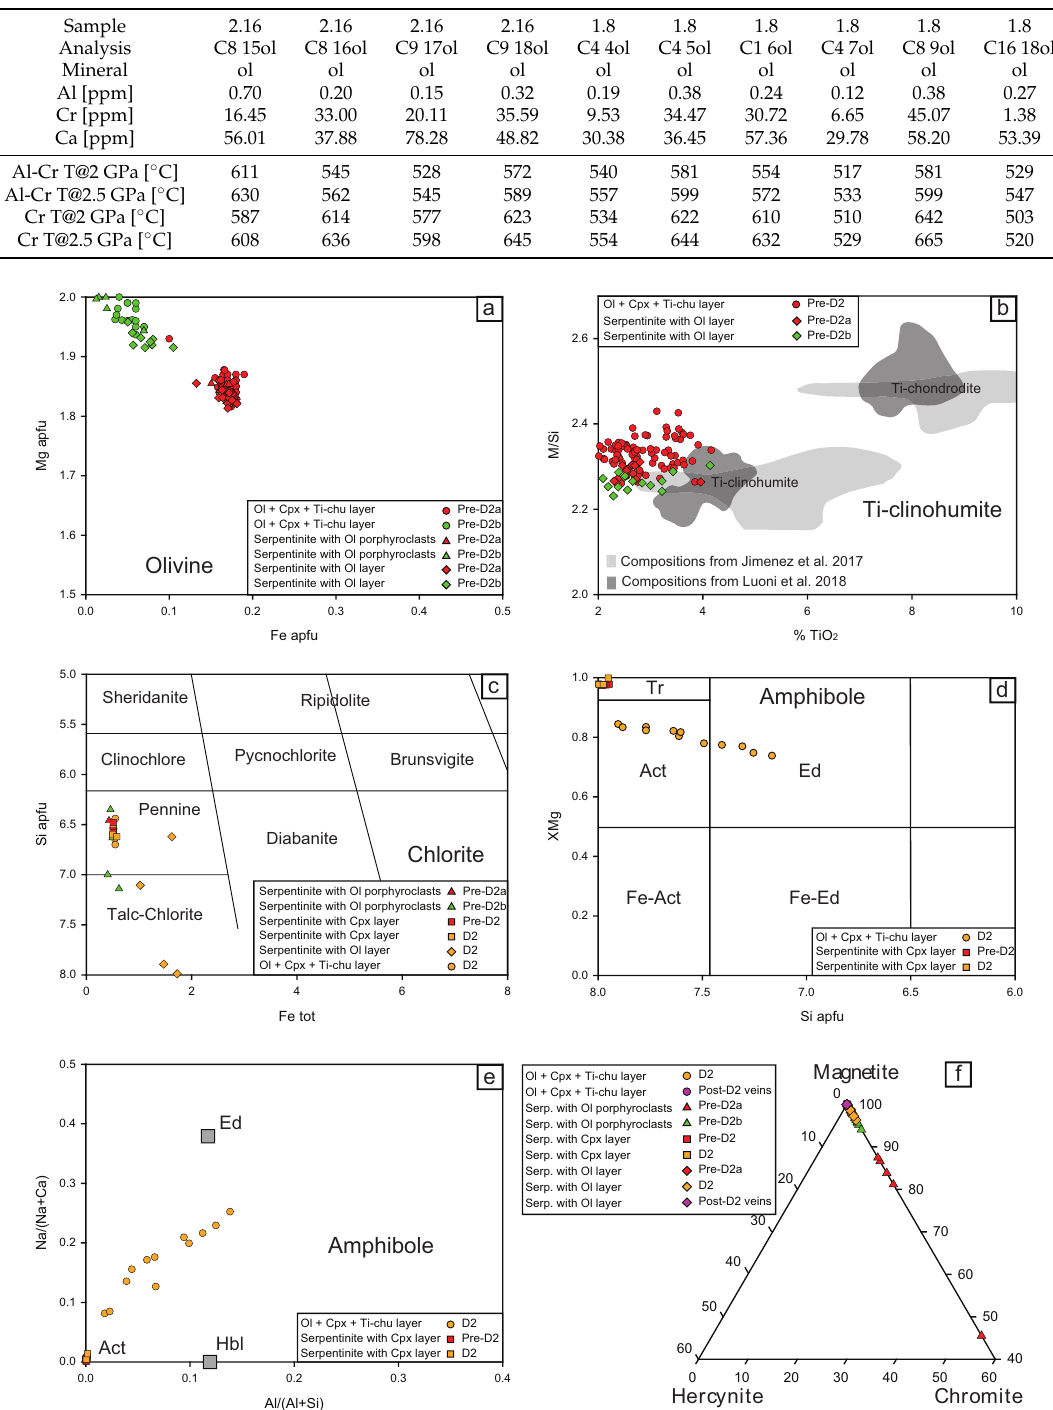
Table 3. Olivine trace element compositions used for thermometry and temperature estimates at 2 and 2.5 GPa.